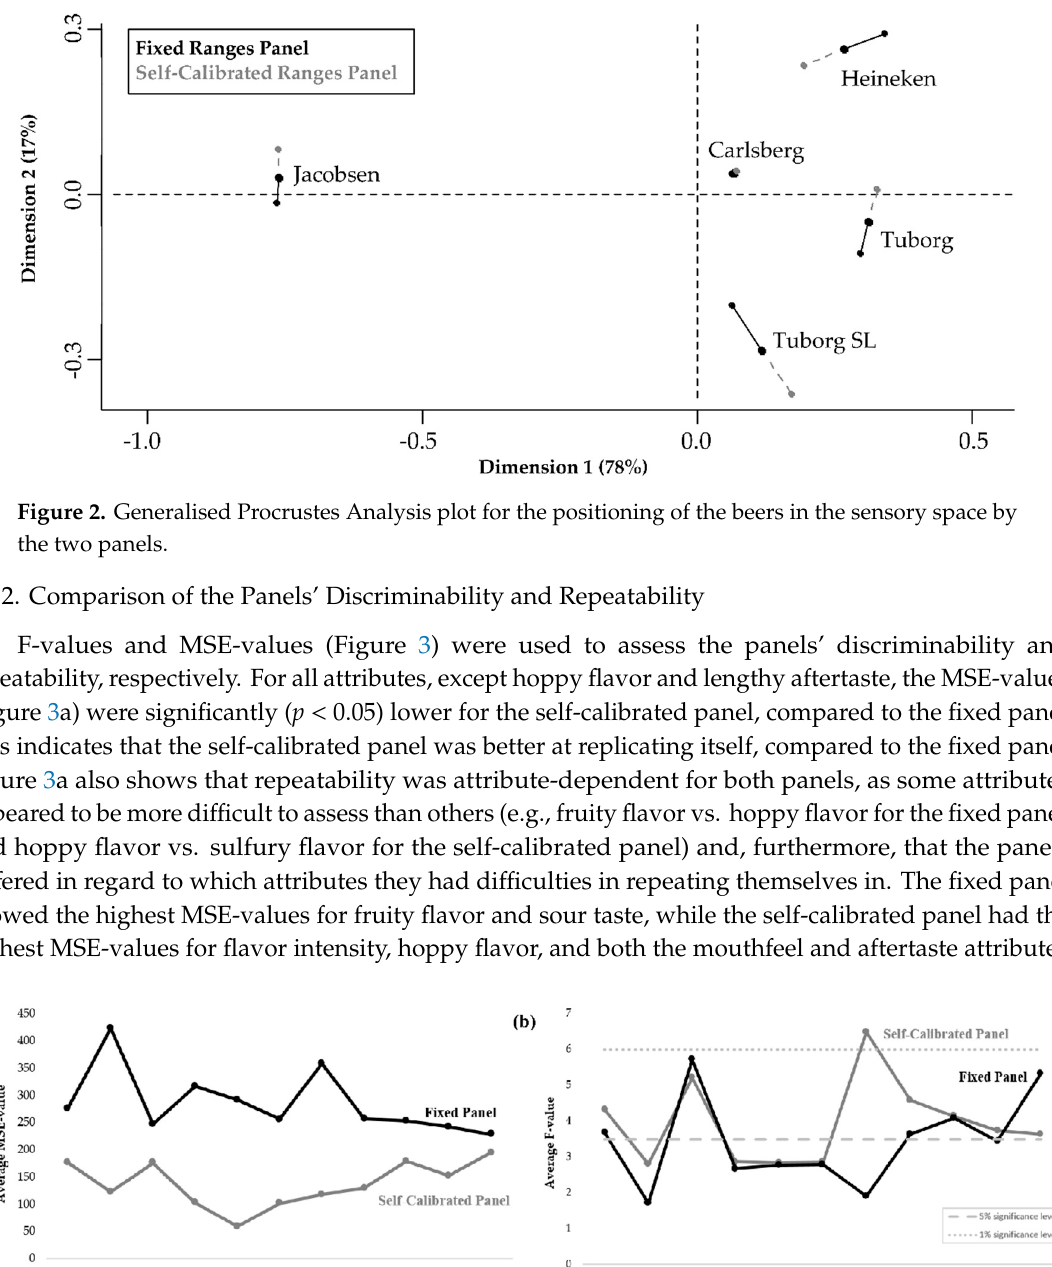
Figure 2. Generalised Procrustes Analysis plot for the positioning of the beers in the sensory space by the two panels.